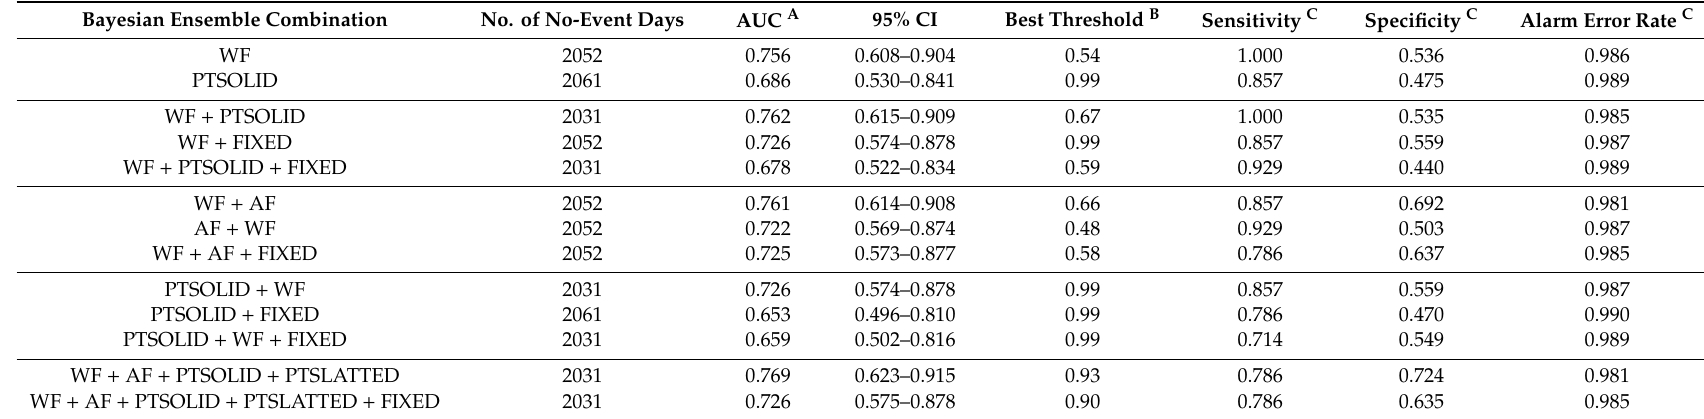
Table 3. Predictive performance of chosen Bayesian ensemble combinations tested in a real-life setting using the alarm type UNTIMED (day-1, day-2 and day-3 included; WF: water flow, AF: activation frequency, PTSOLID: pen temperature above the solid floor, PTSLATTED: pen temperature above the slatted floor, FIXED: fixed probability). All single models and combinations evaluated 14 tail biting